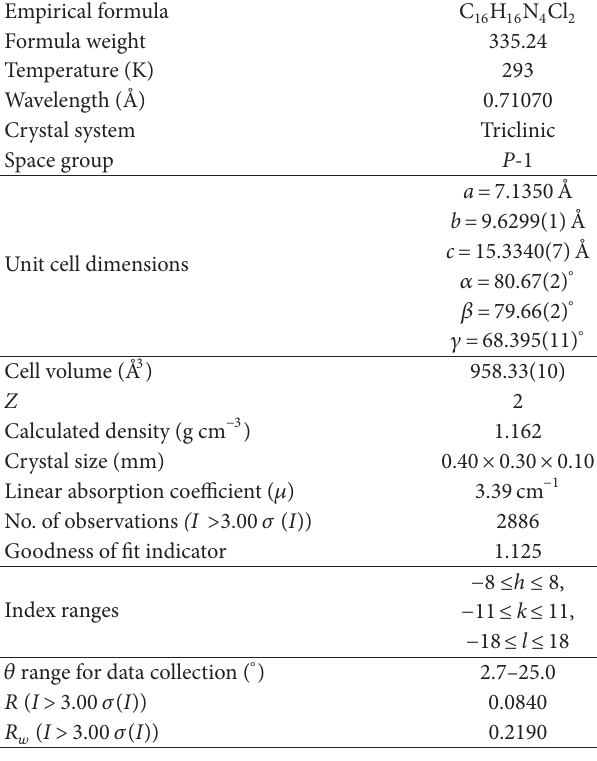
T 1: Crystal and experimental data for the title